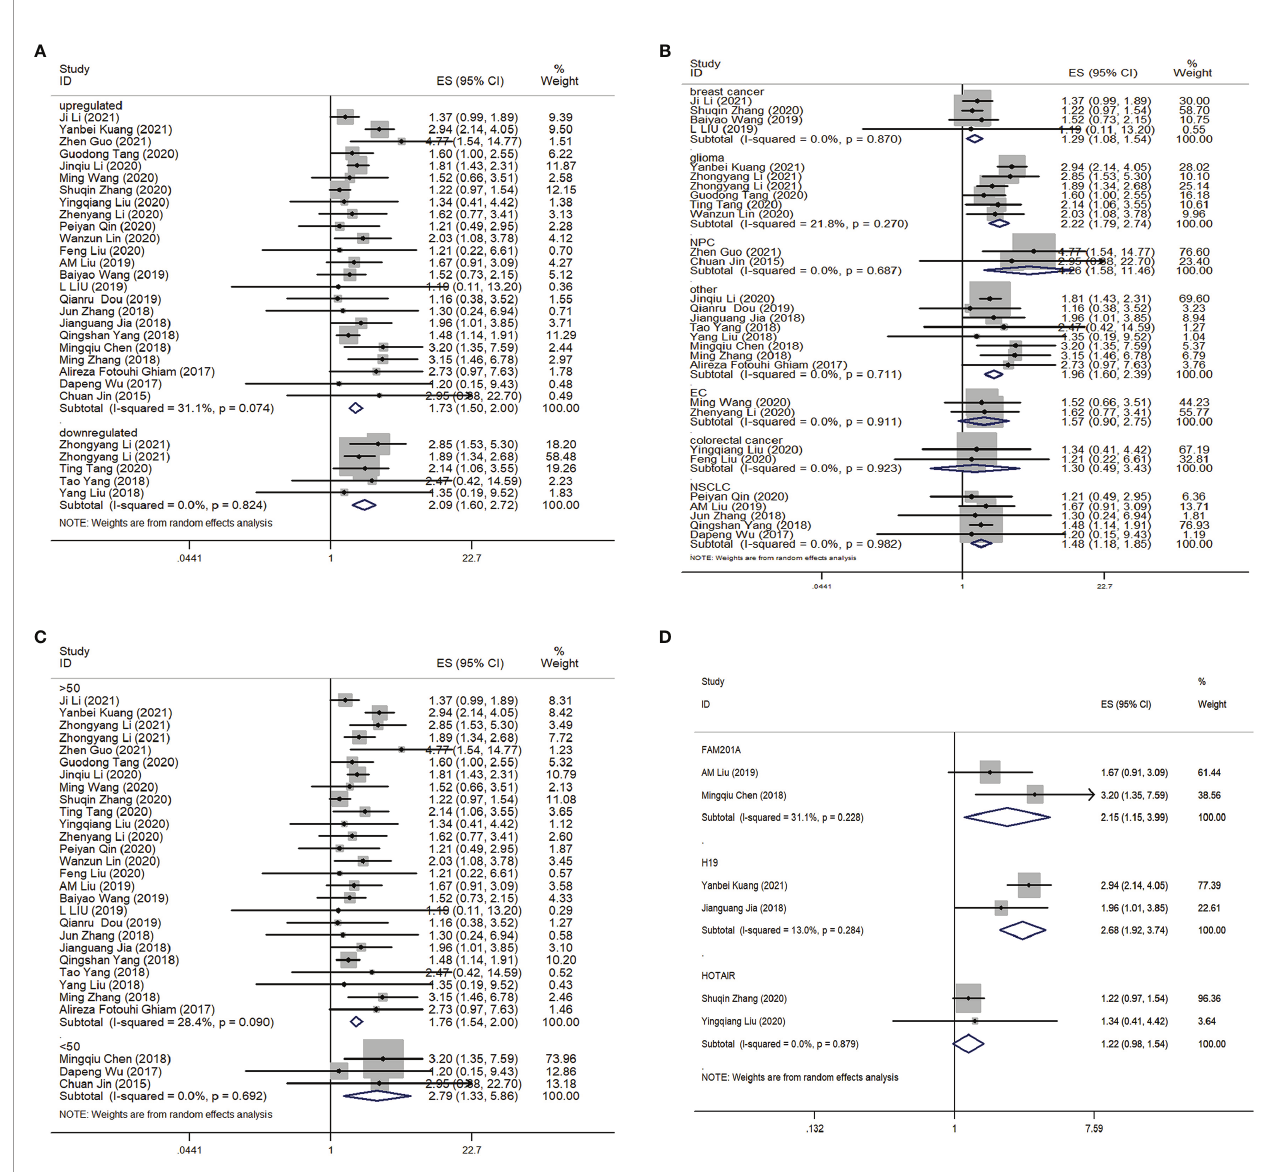
FIGURE 3 | Forest plot for the association between the lncRNAs expression levels with OS. (A) Subgroup analysis of the association between lncRNAs expression level and cancer patients according to the up-regulation and down-regelation of lncRNAs. (B) Subgroup analysis of the association between lncRNAs expression level and cancer patients according to the difference of cancer types. (C) Subgroup analysis of the association between lncRNAs expression level and cancer patients according to the difference of samples size. (D) Subgroup analysis of the association between different lncRNAs expression level and the OS of cancer patients. OS, overall